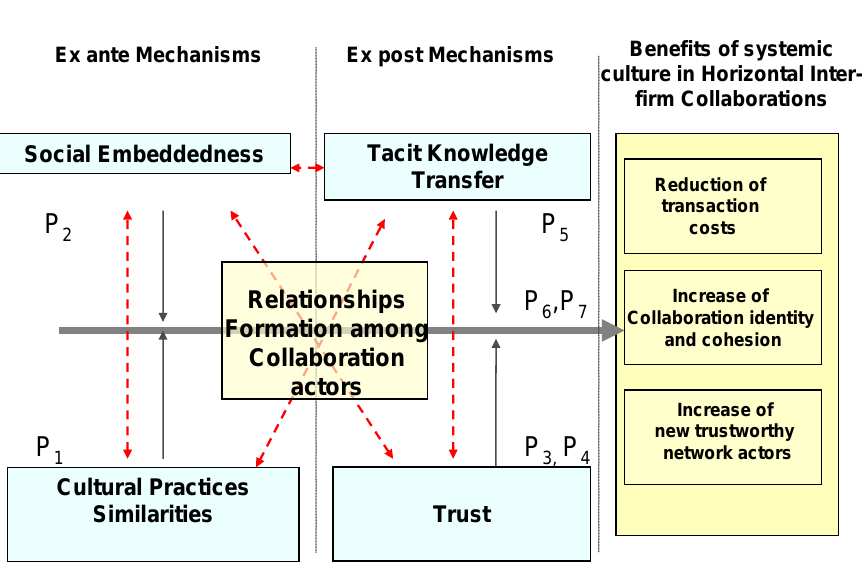
Figure 6. “Conceptual framework of systemic culture in